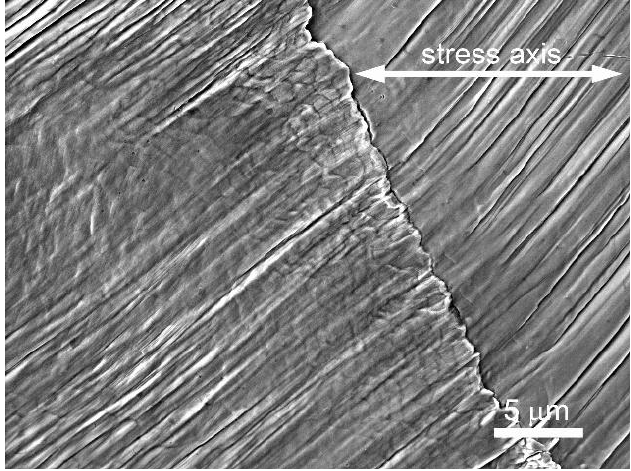
Figure 2. Surface of the grain od polycrystalline copper cycled with high strain amplitude ( ε a = 4 × 10 − 3 ) to the end of the fatigue life.